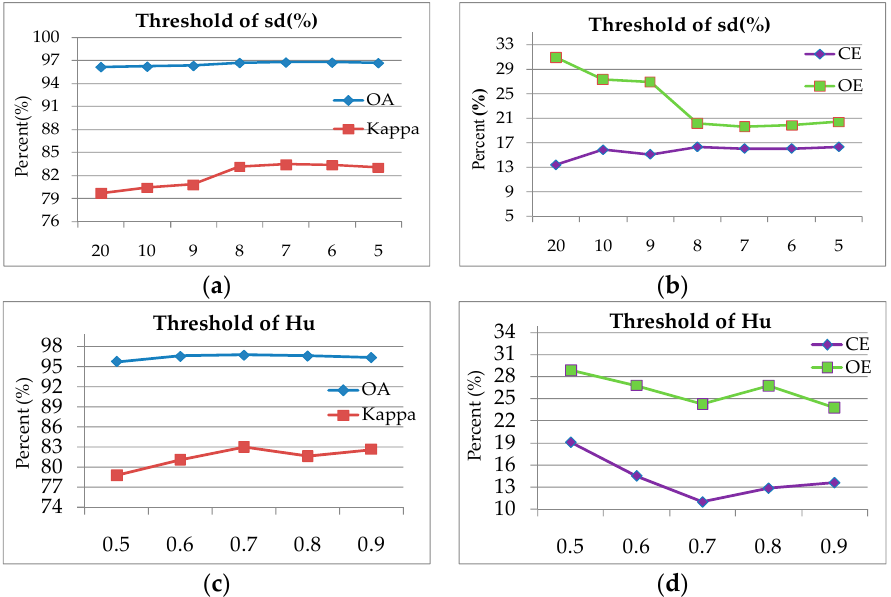
Figure 15. Relationship between building detection accuracies and the thresholds of attributes sd and Hu for Dataset 2.